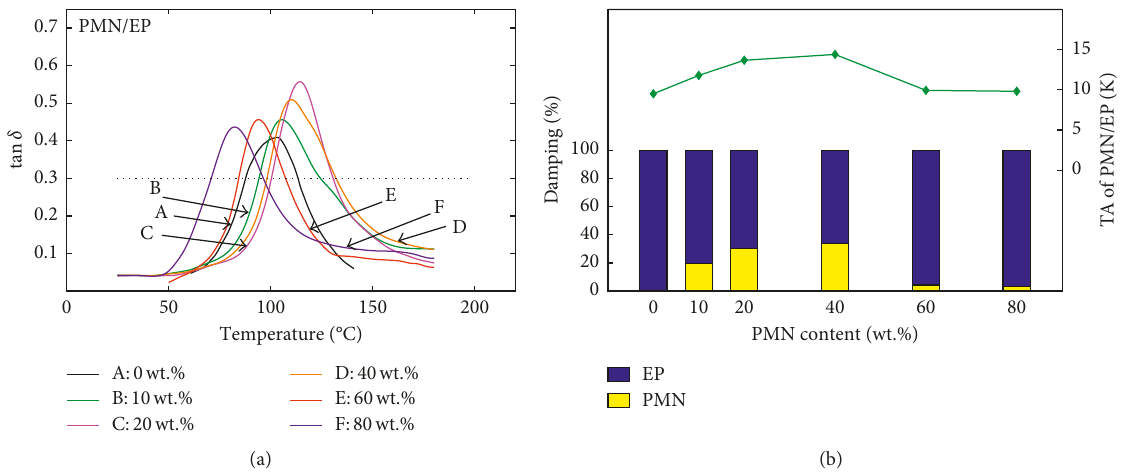
Figure 4: Damping properties of PMN/EP composites as a function of PMN content: (a) loss factor curves; (b) TA values and damping